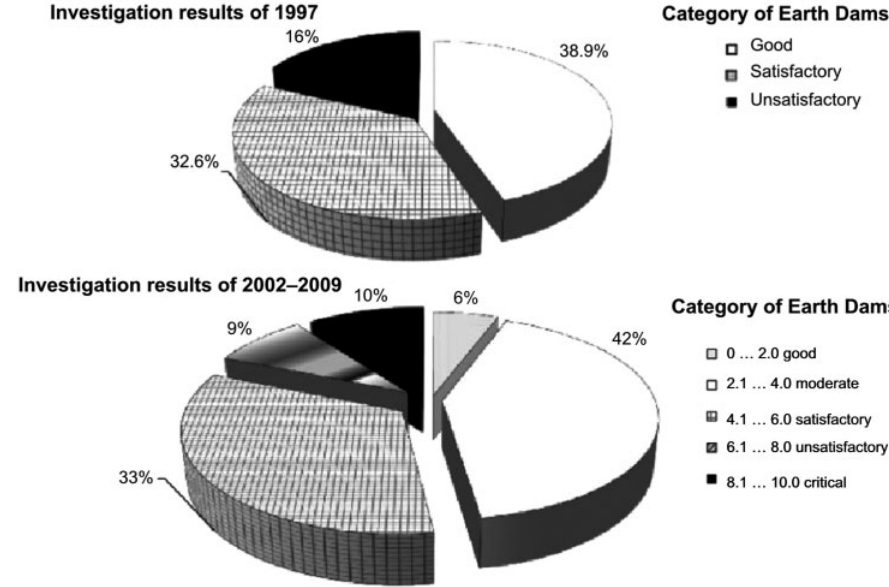
Fig. 3. 1997 and 2002 to 2009 years ED technical state assessment comparative